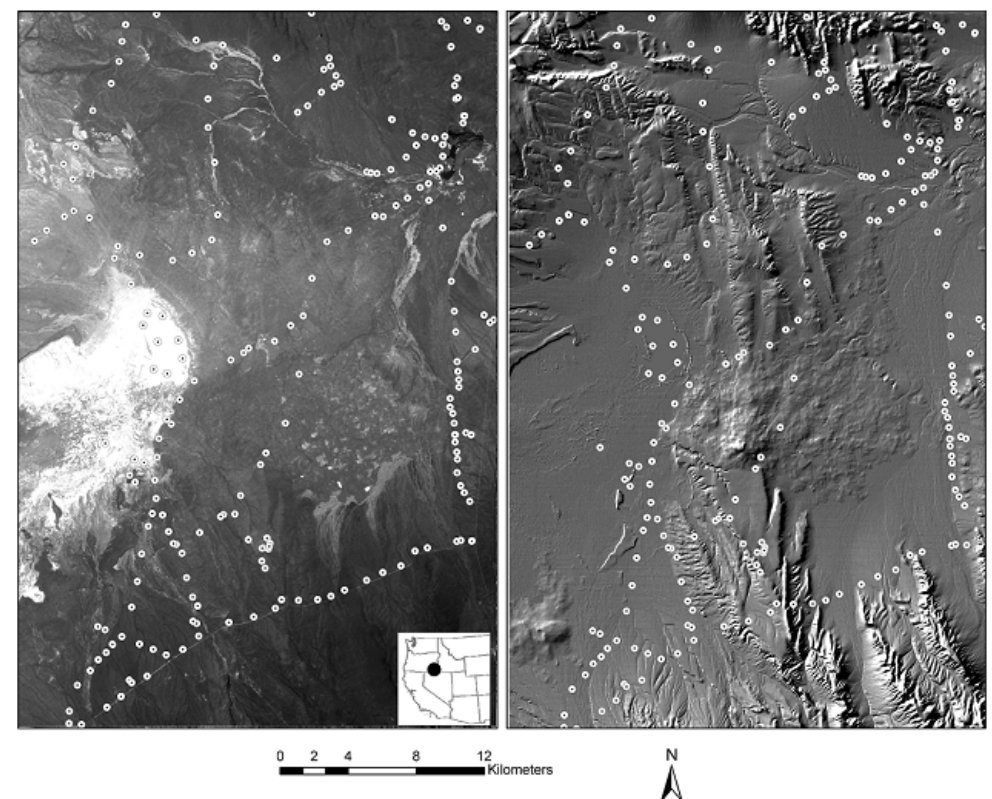
Figure 1. Study area, in Malheur County, southeastern Oregon, USA (see inset map), represented by a Landsat TM image of study area (left) and IFSAR DEM with hillshade (right). Both images have the overlay of soil pits and sampling